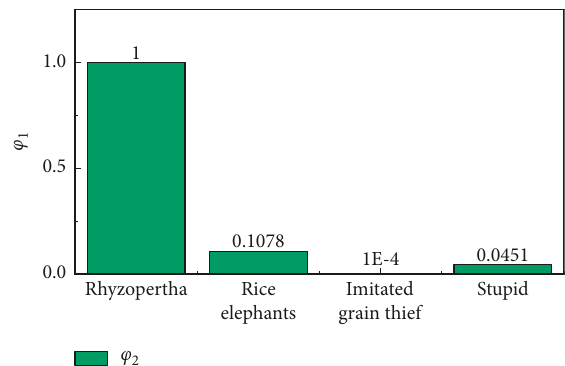
Figure 6: Normalized eigenvalues of identified pests ( φ